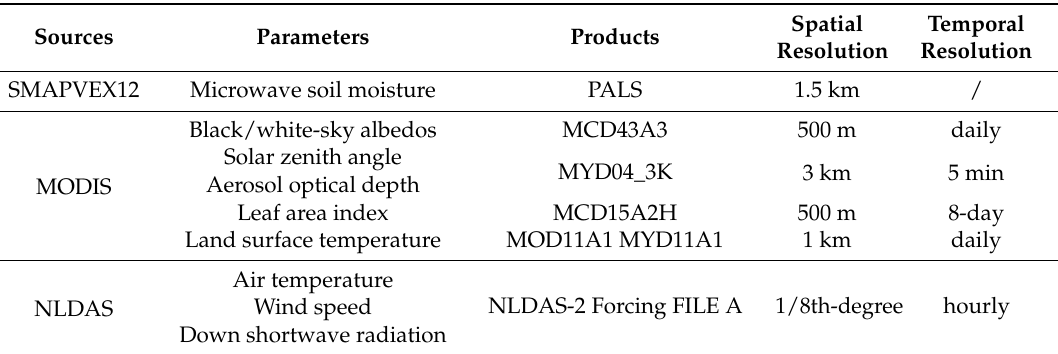
Table 1. Material information used in this